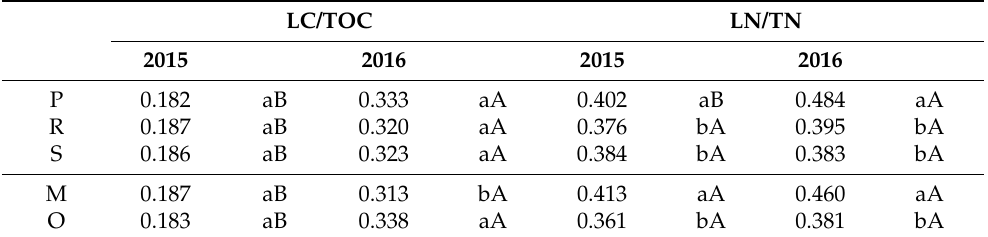
Values belonging to the same treatment with different letters in columns for tillage or fertilization effects (lower case letter), and in rows for year effect (upper case letter) are statistically different according to LSD (0.05). P = Plowing; R = Subsoiling; S = Spading; M = Mineral; O =